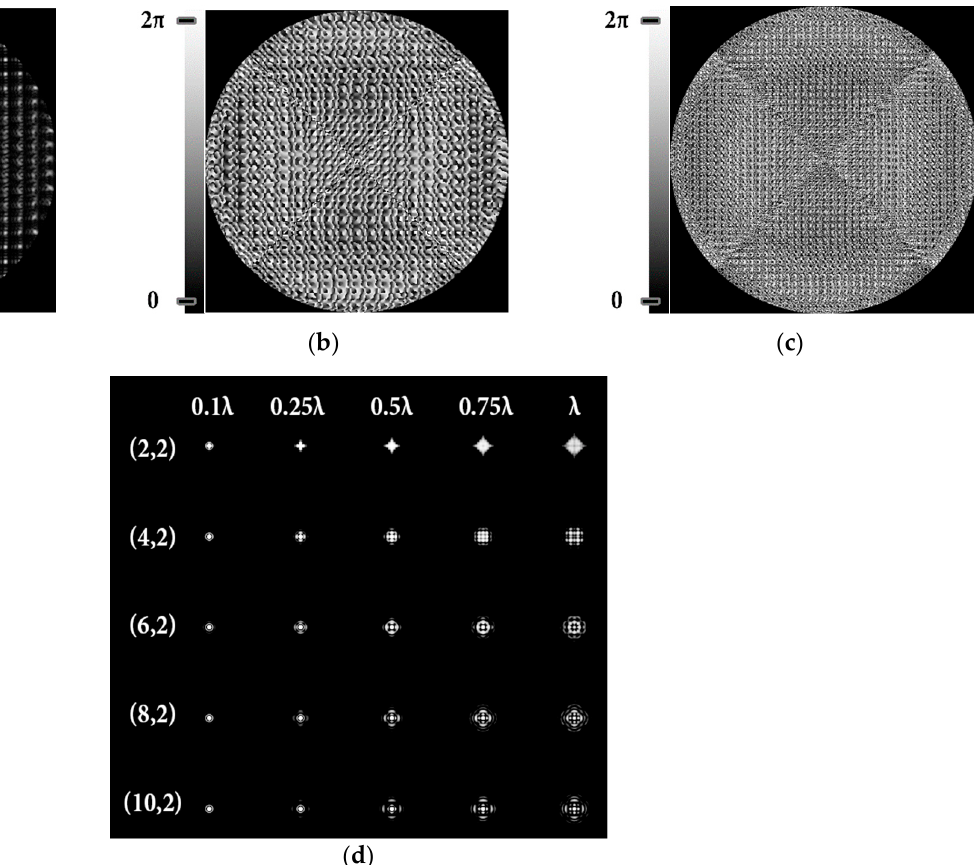
Figure 2. Amplitude ( a ) and phase ( b ) of a 25-channel amplitude-phase DOE, ( c ) the coded phase of DOE matched to different astigmatic aberrations Z n ,2 ( r , ϕ ) ( n = 2, 4, 6, 8, 10) with various levels α j ,